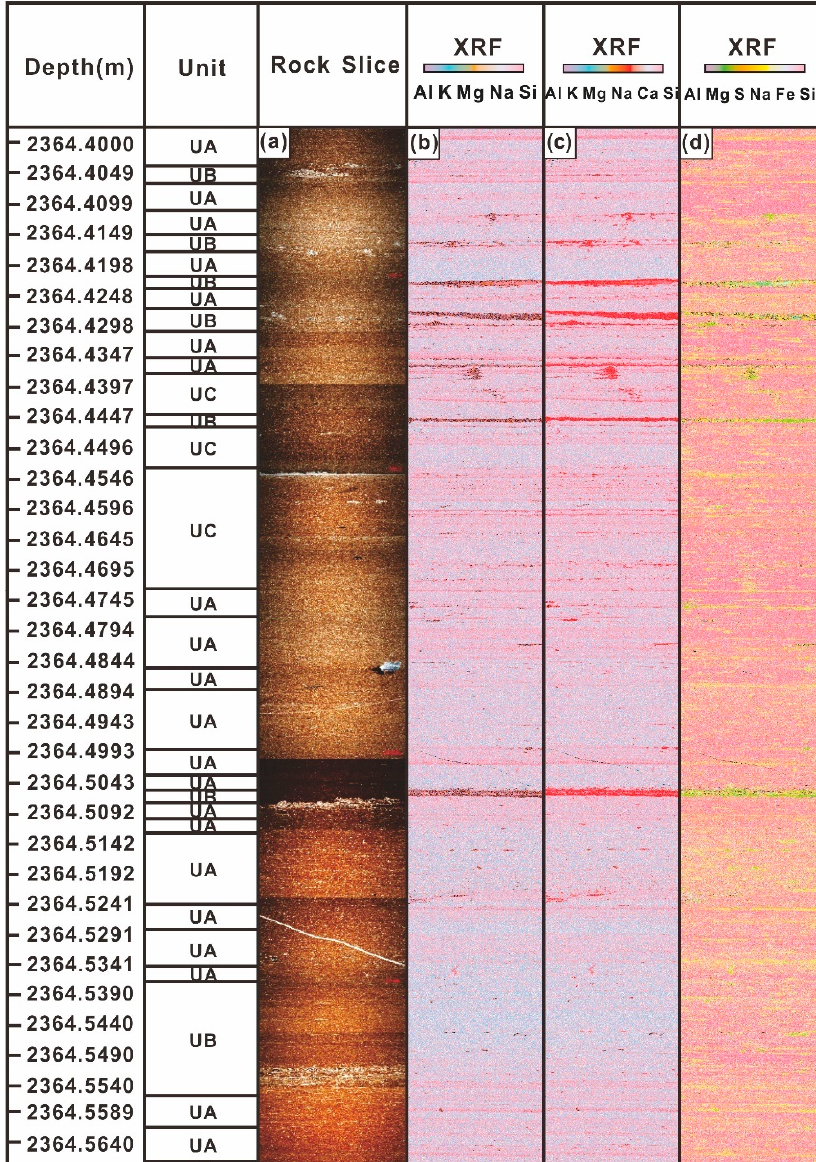
Figure 2. Laminae division based on XRF and rock thin section.